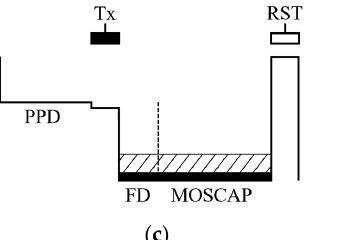
Figure 4. Timing diagram: ( a ) Single charge transfer; ( b ) Multiple charge transfer.